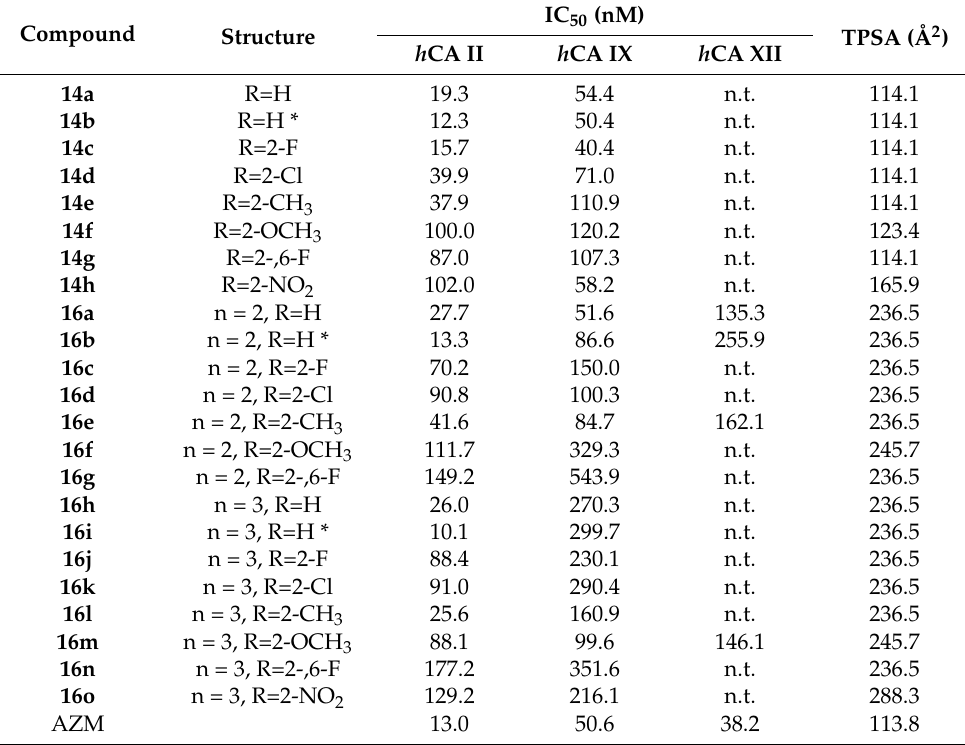
Table 1. The IC 50 of the compounds 14a–h and 16a–o against h CA II, IX, and XII. Compound